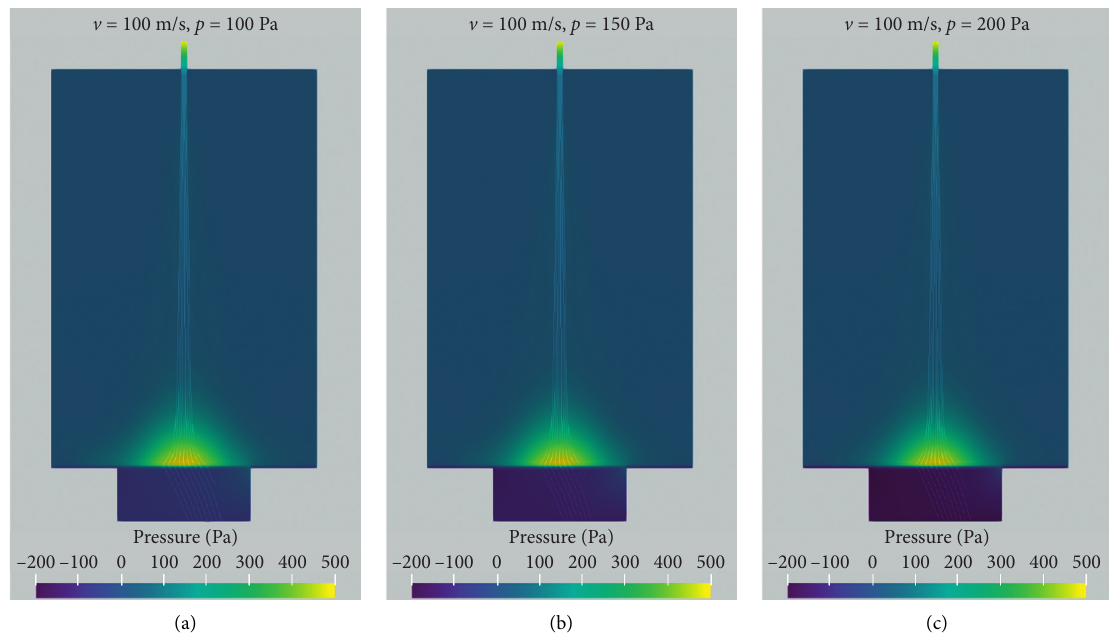
Figure 5: Comparison of the pressure in the entangling zone for varying suction pressure. (a) 100Pa, (b) 150 Pa, and (c) 200Pa, while the inlet speed at the end of the drawing unit is fixed at v � 100m/s.